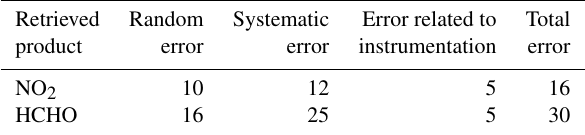
Table 2. Estimated errors (%) for the NO 2 and HCHO concentra- tion in the 0–1km layer, retrieved using the JM2